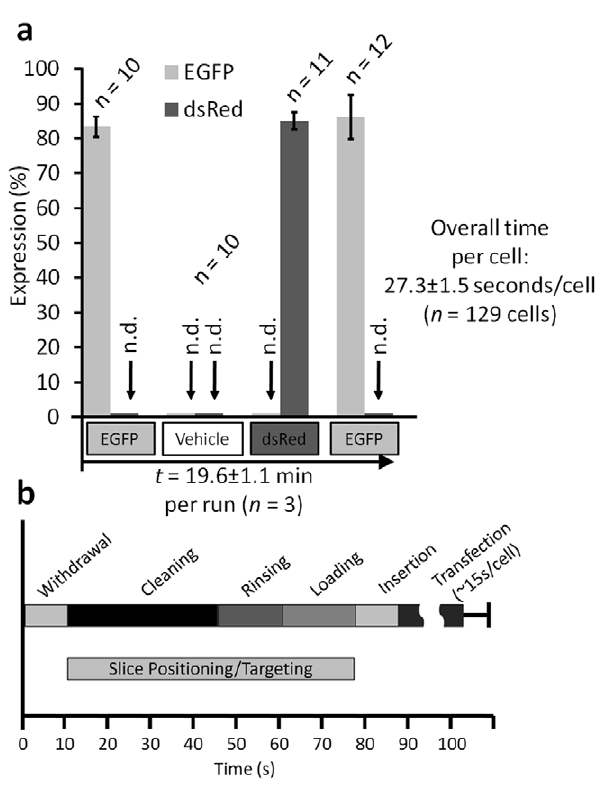
Figure 3. Rapid Transformation of Single Cells with Different Reagents with No Cross-Contamination. (a) Sequential transfec- tions were carried out on groups of single cells using the same micropipette, in which pCAG-EGFP was transfected first (efficiency: 83.3 6 2.9%), followed by a reagent containing only the fluorescent vehicle solution (plasmid contamination: 0%), then pCAG-dsRed (efficiency: 85 6 2.9%, plasmid cross-contamination: 0%), and finally pCAG-EGFP again (efficiency: 86.1 6 6.4%, plasmid cross-contamination: 0%). The entire sequence took 19.6 6 1.1 minutes. (n.d.=not detected) Results are mean 6 s.d. of three independent experiments in which 129 total cells were transfected. (b) Average time of different steps in a full transfection cycle. Withdrawal, cleaning, rinsing, loading, and insertion to slice bath of the micropipette takes 88.9 6 8.6 seconds (from four independent experiments, n=25 per experiment).